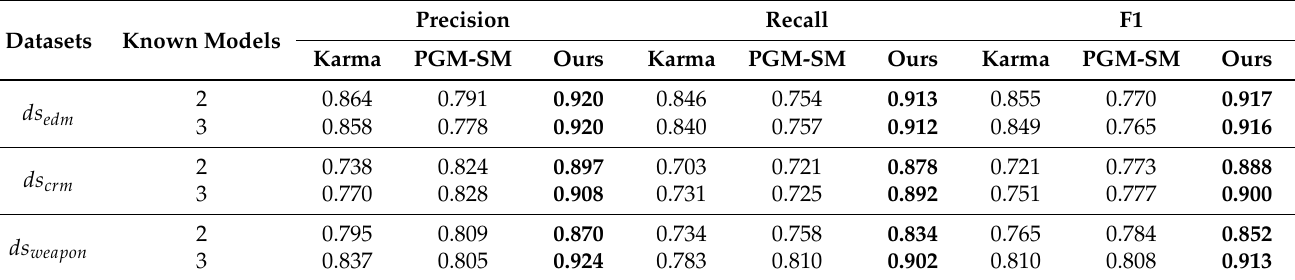
Table 4. Performances of our method on ds edm , ds crm , and ds weapon